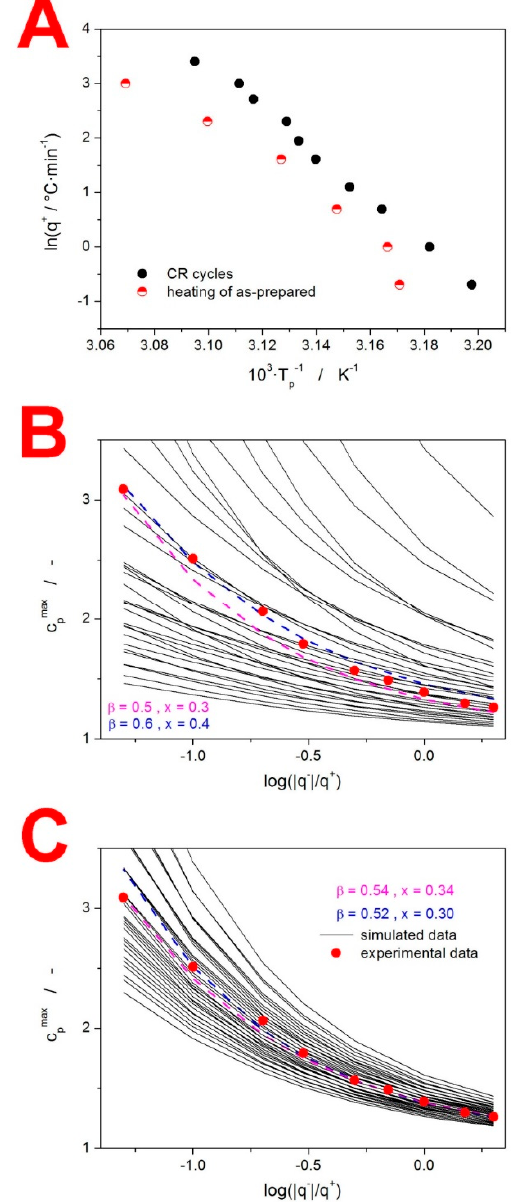
Figure 4. ( A ) Evaluation of ∆ h* by applying Equation (3) to the CR cycles and to the single heating scans of the as-prepared IMC material (examples of these scans are shown in Figure 1). ( B ) Application of the simulation-comparative method to the CHR relaxation measurements of the amorphous IMC: 1st round. Experimental data points. Black solid lines refer to simulated data for the various combinations of the TNM parameters β and x (both parameters changing with the coarse step). Colored dashed lines refer to the two simulated β + x combinations best fitting the experimental data. ( C ) Application of the simulation-comparative method to the CHR relaxation measurements of the amorphous IMC: 2nd round. Experimental data points. Black solid lines refer to simulated data for the various combinations of the TNM parameters β and x (both parameters changing with the fine step). Colored dashed lines refer to the two simulated β + x combinations best fitting the experimental data.